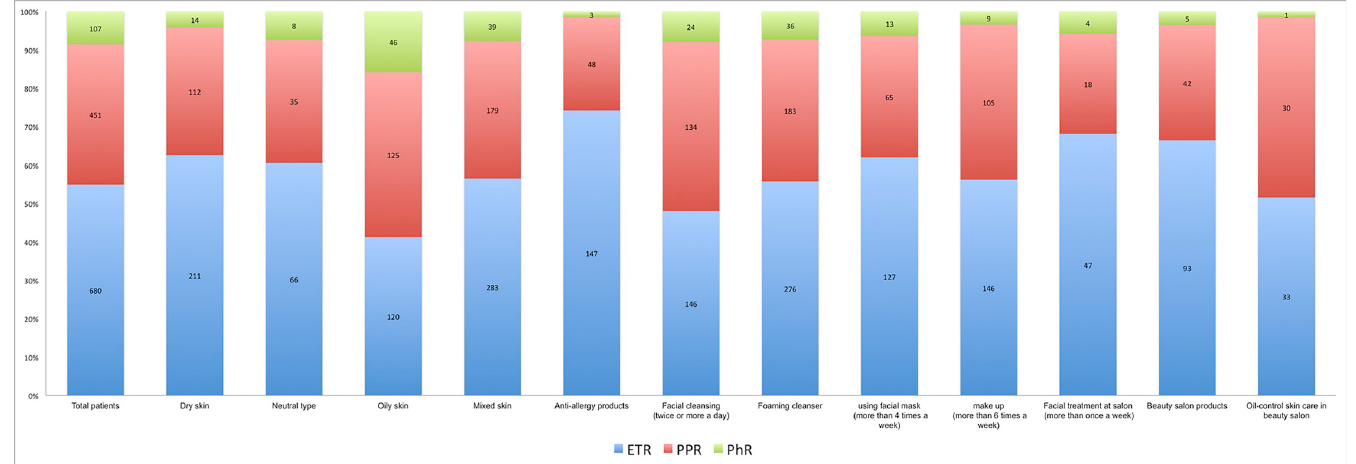
Fig 1. The proportion of the subtypes of ETR, PPR, PhR in groups of rosacea patients with different high-risk factors. ETR was the most dominant subtype in the group of patients using anti-allergy products, PPR accounted for the relative highest proportion in the group of patients doing oil-control skin care in the beauty salon, and the relative proportion of PhR in the group of patients with oily skin was the